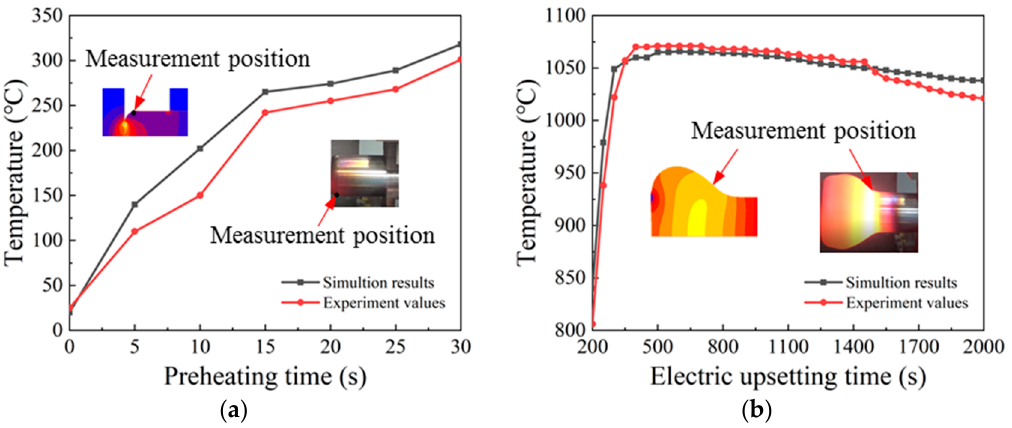
Figure 24. Comparison between simulation temperature and experimental one during different processes: ( a ) the preheating process, and ( b ) the forming process.